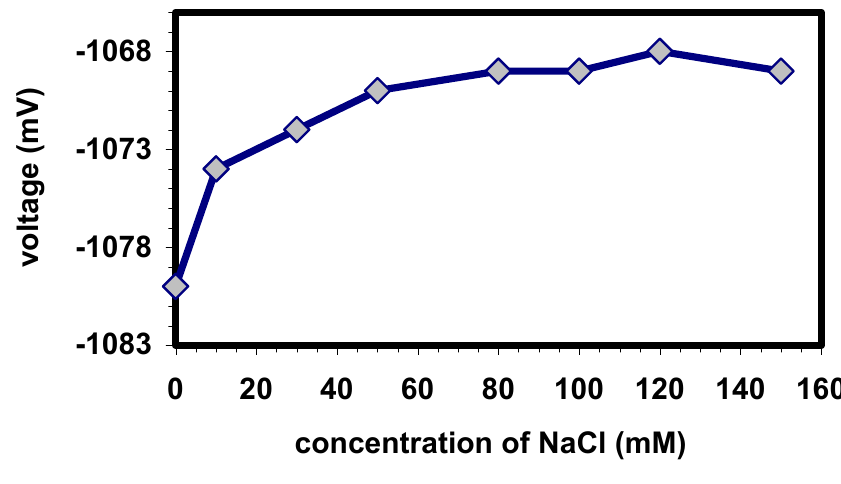
Figure 5. Effect of conductivity of the HEPES buffer (1 mM) on the signal amplitude of the EIS biosensor at 50 µM paraoxon.